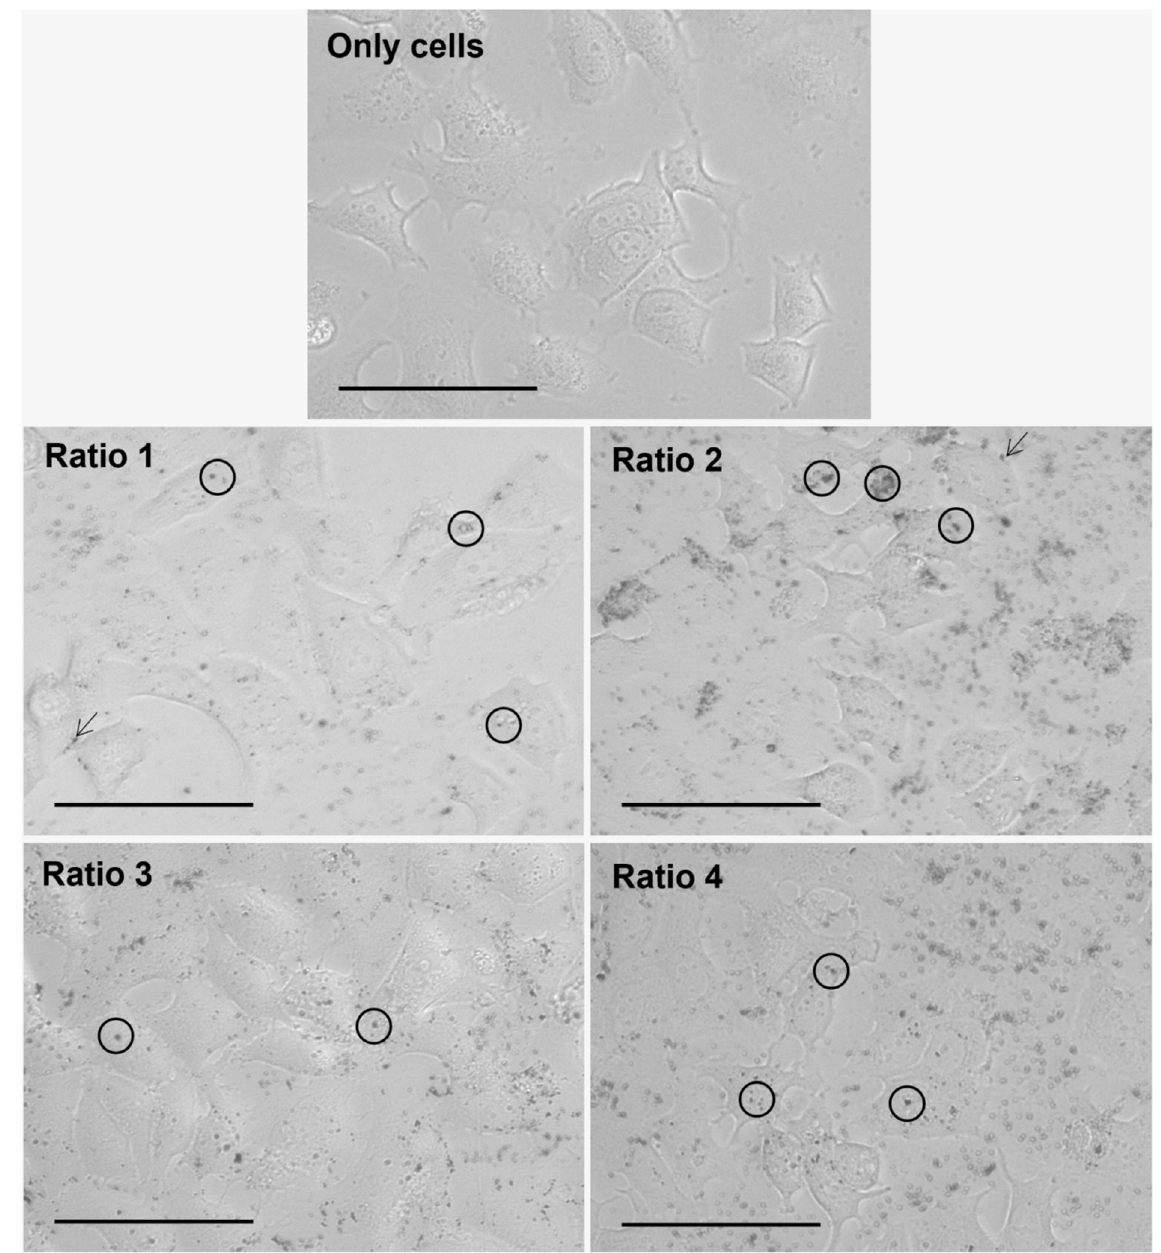
Figure 10. Representative images of MCF-7 cells alone (only cells) and after 4 h of incubation with different types of AuNPs (Ratio 1, Ratio 2, Ratio 3 and Ratio 4 AuNPs) at 40 × magnification. AuNPs appear as darker structures either inside the cell (circle) or at the cell surface (arrow). Scale bar = 75 µm.